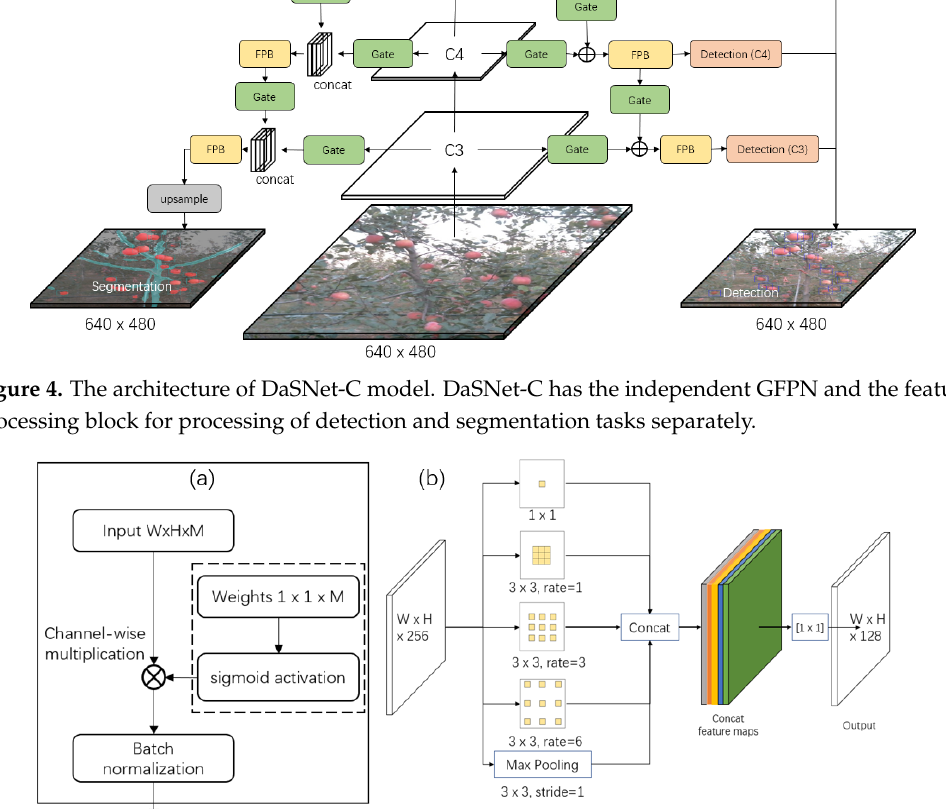
Figure 5. ( a ) The architecture of gate in the GFPN; and ( b ) the architecture of ASPP in the feature processing